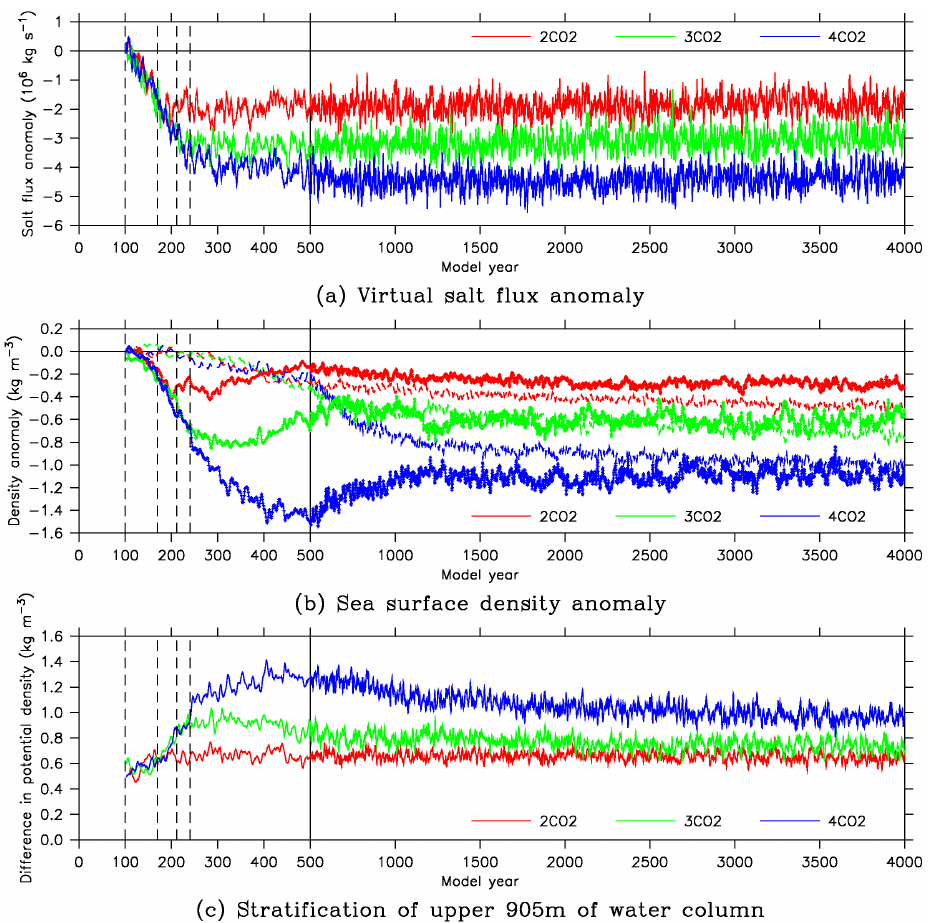
Fig. 24. The changes in the North Atlantic (50–65 ◦ N) during experiments 2CO2 (red), 3CO2 (green) and 4CO2 (blue): (a) the area-integrated virtual salt flux, expressed as an anomaly relative to the first century of CONTROL; (b) the mean changes in the sea surface density, relative to the first century of CONTROL, due to changes in temperature (dashed lines) and salinity (solid lines); and (c) the mean stratification of the upper 905m of the water column, defined as the difference in σ 905 between a depth of 905m and the surface. The values shown are five-year running means and vertical dashed lines indicate model years 100, 170, 211 and 240. Note the change in the scale of the time axis at year